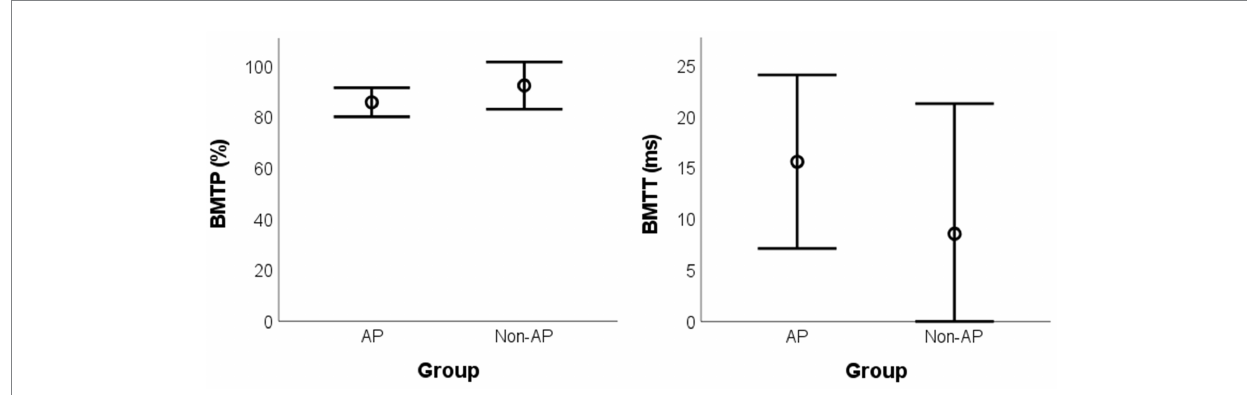
FIGURE 3 Mean values for the BMT parameters according to the group. BMT: Backward Masking Test; AP: absolute pitch; BMTP: BMT percentage of correct responses; BMTT: BMT target sound detection